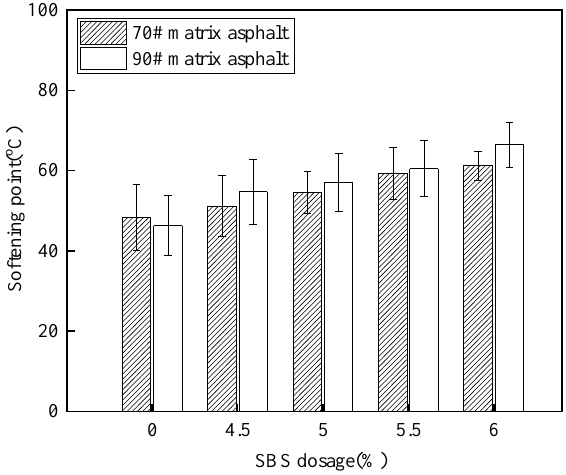
Figure 2. Softening point of matrix asphalt and SBS modified asphalt.